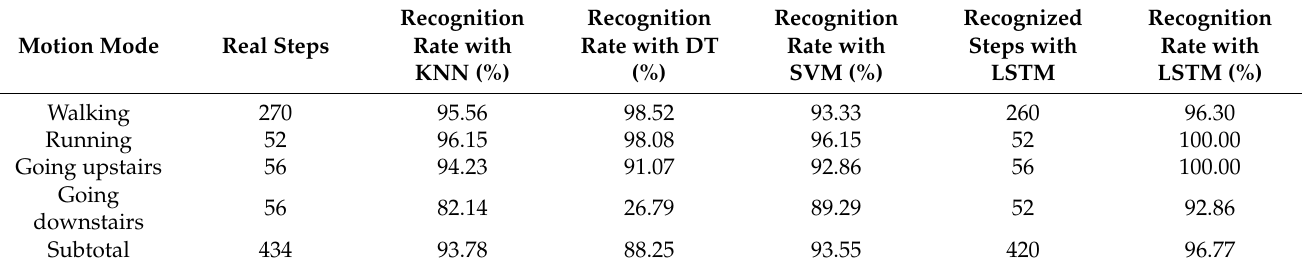
Table 3. Recognition results of multi-motion